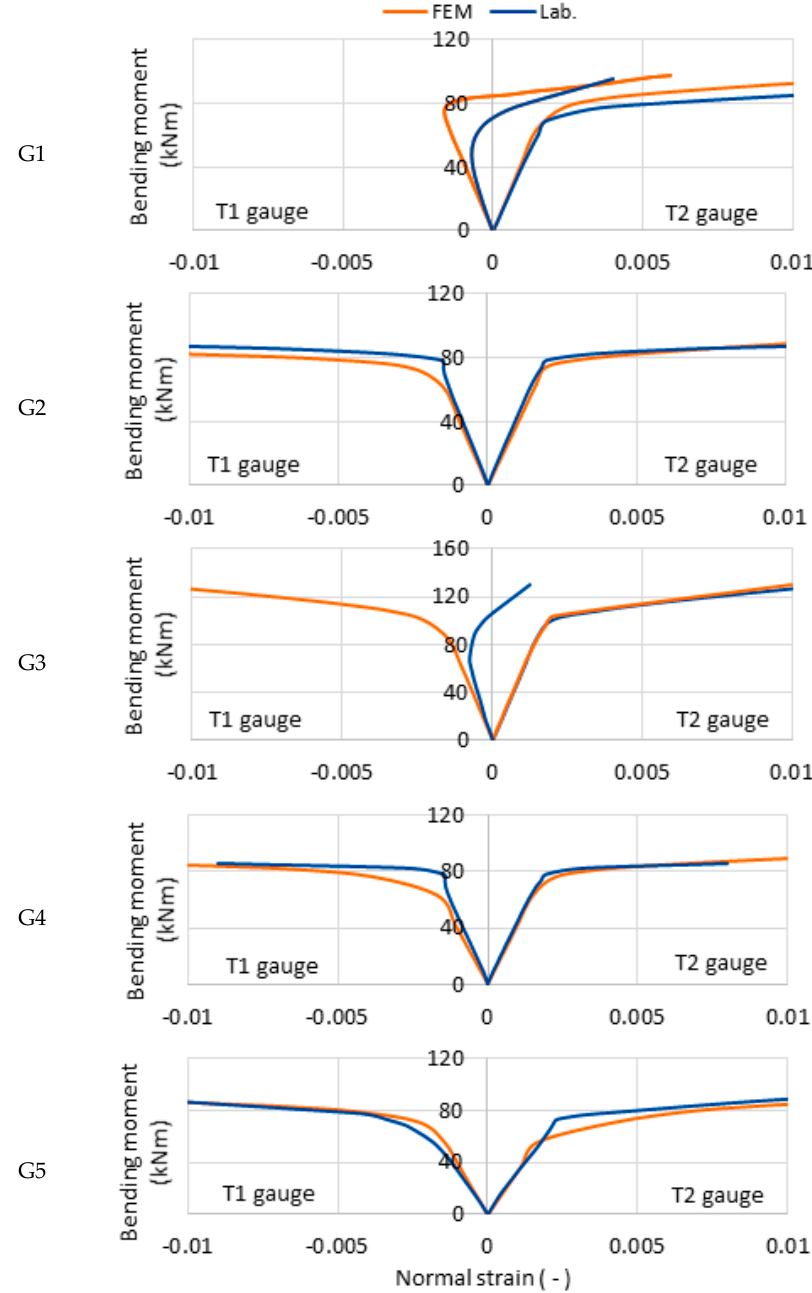
Figure 10. Moment–strain relationship diagram obtained from the laboratory tests and numerical simulations of five naturally corroded beams ( G1 – G5 ). The strain readings at the top wall (under compression, T1) are shown on the left, whereas the strain reading at the bottom wall (under tension, T2) are shown on the right. The moment–strain curves achieved from the laboratory tests and numerical simula- tions show very good agreement. The moment–strain curves on the compression wall show greater nonlinearity related to the loss of local stability due to compressive stresses